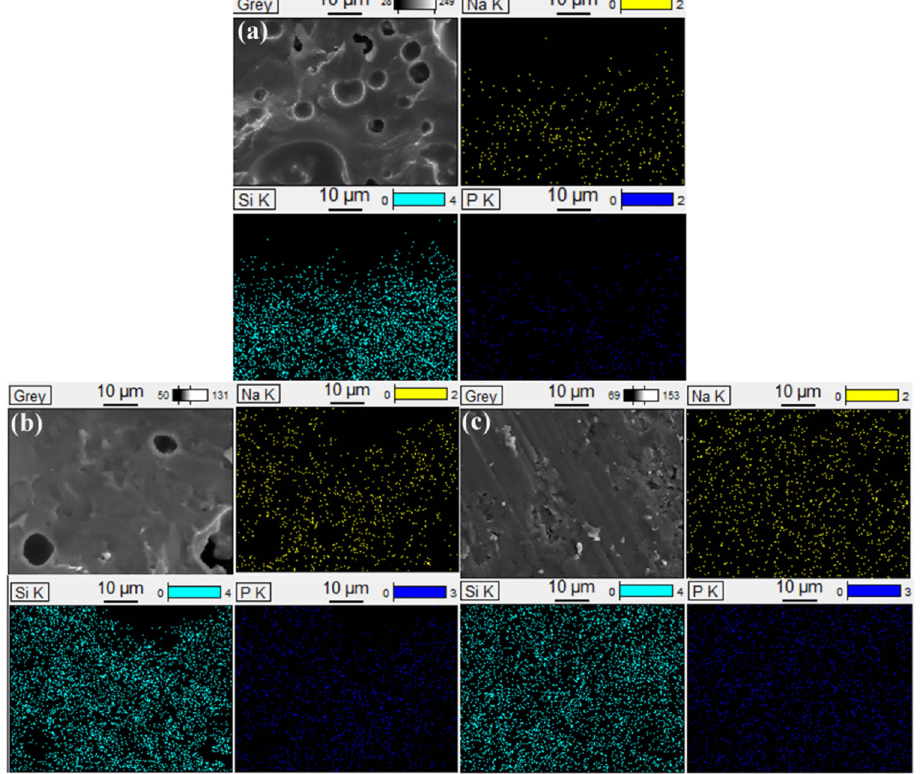
Figure 9. Elemental distribution mappings for the cross-sections of SSP-2 fired at different temperature; ( a ) 700 °C, ( b ) 850 °C, and ( c ) 1000 °C.